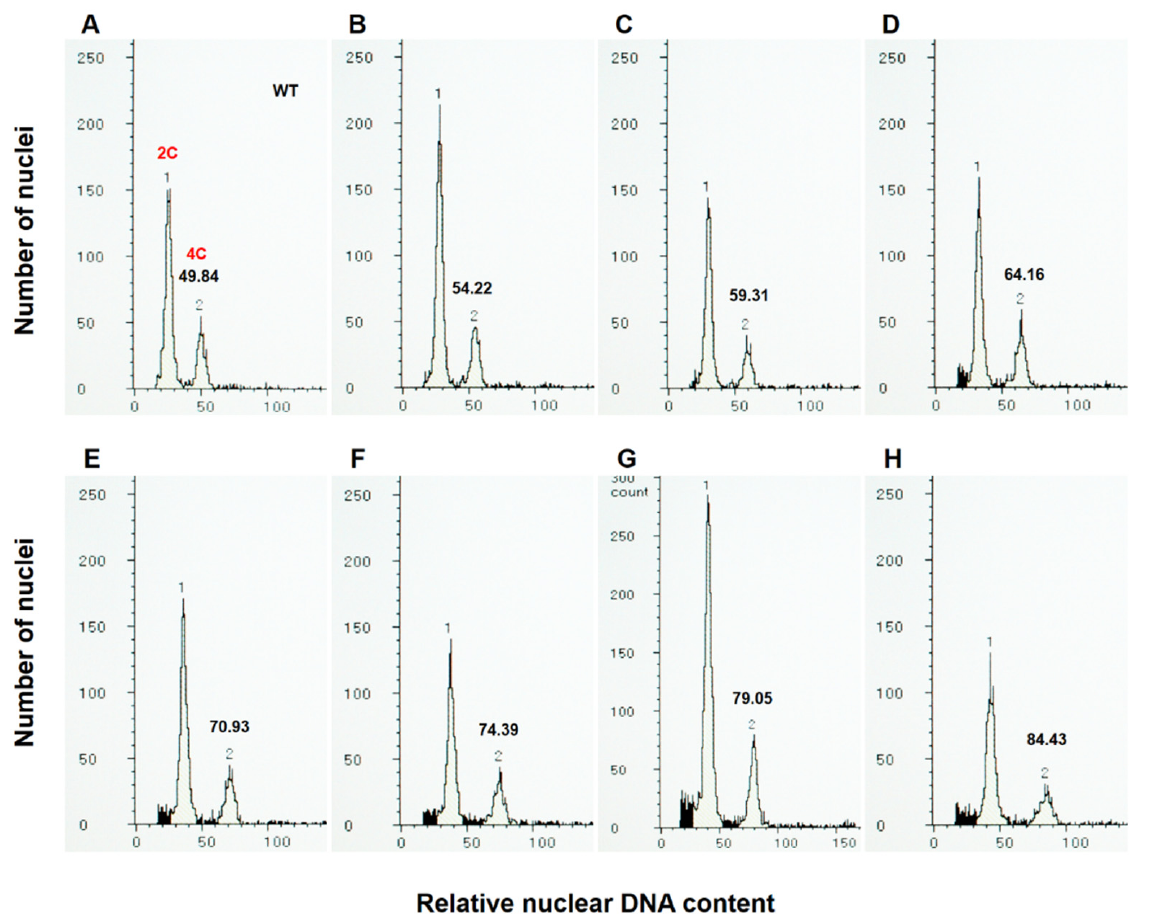
Figure 5. Histograms of flow cytometric analysis on the F1 plants from the cross between the WT and ubc22-1 mutant with the WT as the paternal parent. Flow cytometry was performed using floral bud tissues of individual plants, and nuclei were stained with DAPI. The parameters of the flow cytometry were set so that the average WT 4C peak value was about 50. ( A ) Histogram of a control WT plant, showing two major peaks that represent nuclei with 2C and 4C DNA contents. ( B – H ) Histograms of F1 plants with various 4C values higher than 50, indicating that the plants were not diploids. Note that the DNA content in ( F ) is 1.5 times that in the WT ( A ), indicating that the plant had a nuclear DNA content of a triploid, while the other F1 plants were aneuploids.